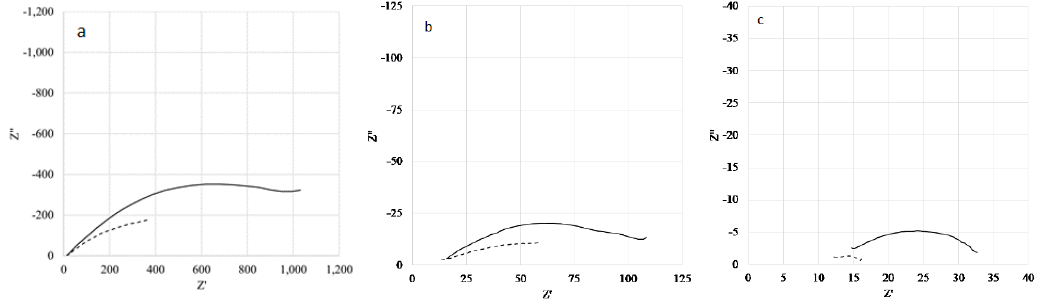
Figure 9. Cu new pipe (continuous curve) and after 8 weeks aging (dotted curve) at 0.0 V ( a ), 0.05 V ( b ), and 0.1 V ( c ) vs. the saturated calomel electrode (SCE).